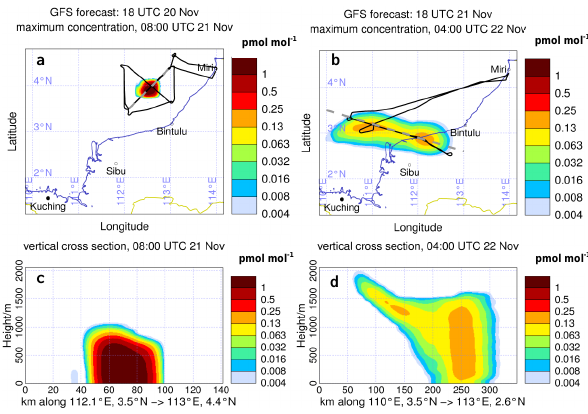
Figure 5. HYSPLIT forecasts of the horizontal and vertical distribution of the PFC concentration at the northern coast of Borneo, 5 h ( a and c ) and 25 h ( b and d ) after the release of the tracer. The flight tracks of the two Falcon sampling flights are also shown (black lines in a and b ). The thick dashed lines (grey) indicate the location of vertical cross sections (c and d)